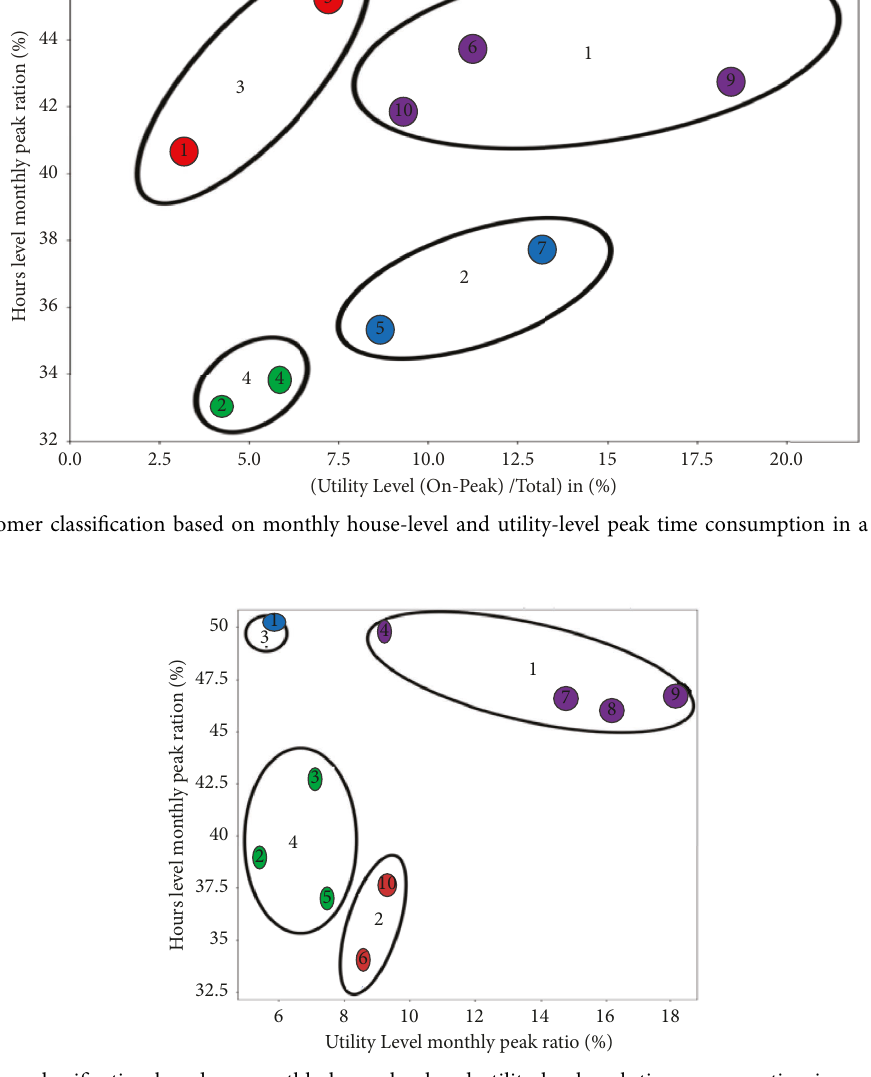
Figure 9: Customer classification based on monthly house-level and utility-level peak time consumption in a nonsummer